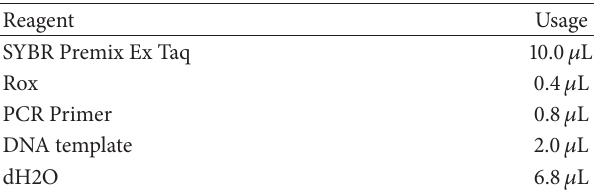
Table 3: qRT-PCR reaction